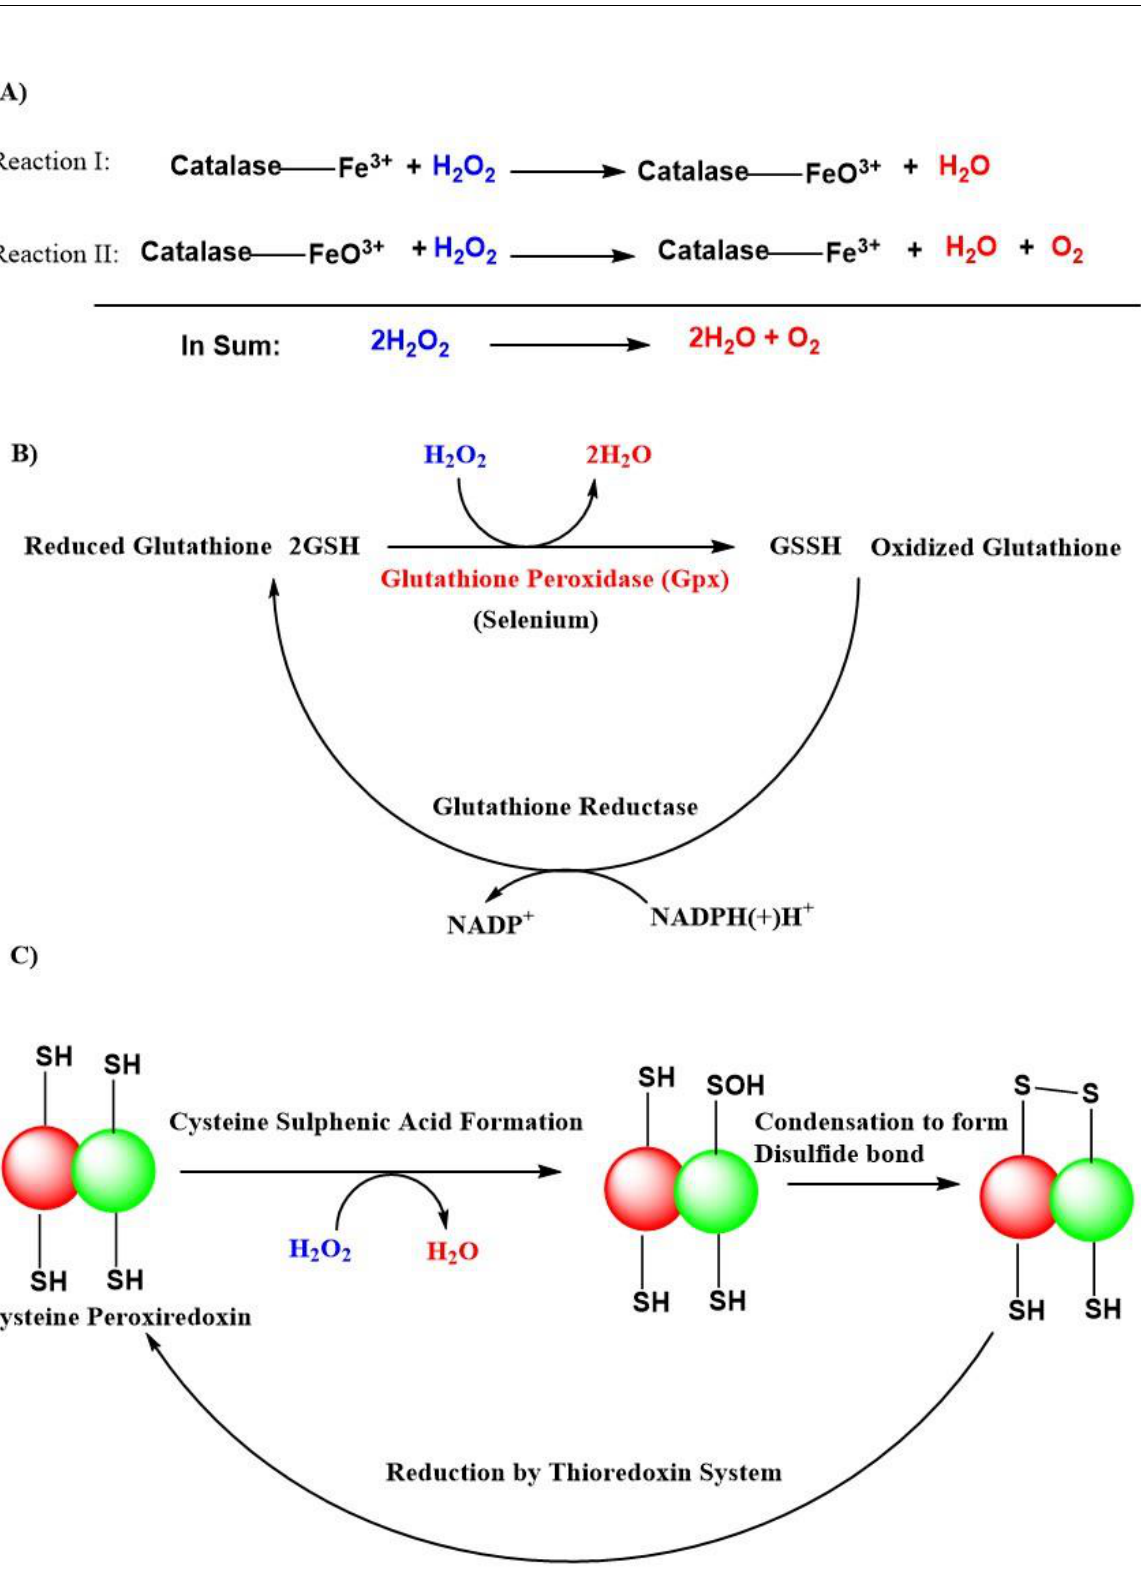
Figure 3. Antioxidant actions of various natural defense systems present in our body to scavenge hydrogen peroxide (H 2 O 2 ). ( A ) Catalase system. ( B ) Glutathione peroxidase (GPxs) system. ( C ) Peroxiredoxin system. Abbreviations: (SH), thiol; (-SOH), sulphenic acid; (-S-S-), disulfide bond; NADP+, nicotinamide adenine dinucleotide phosphate; NADPH(+)H+, reduced nicotinamide adenine dinucleotide phosphate; GSH, reduced glutathione; GSSH, oxidized glutathione.